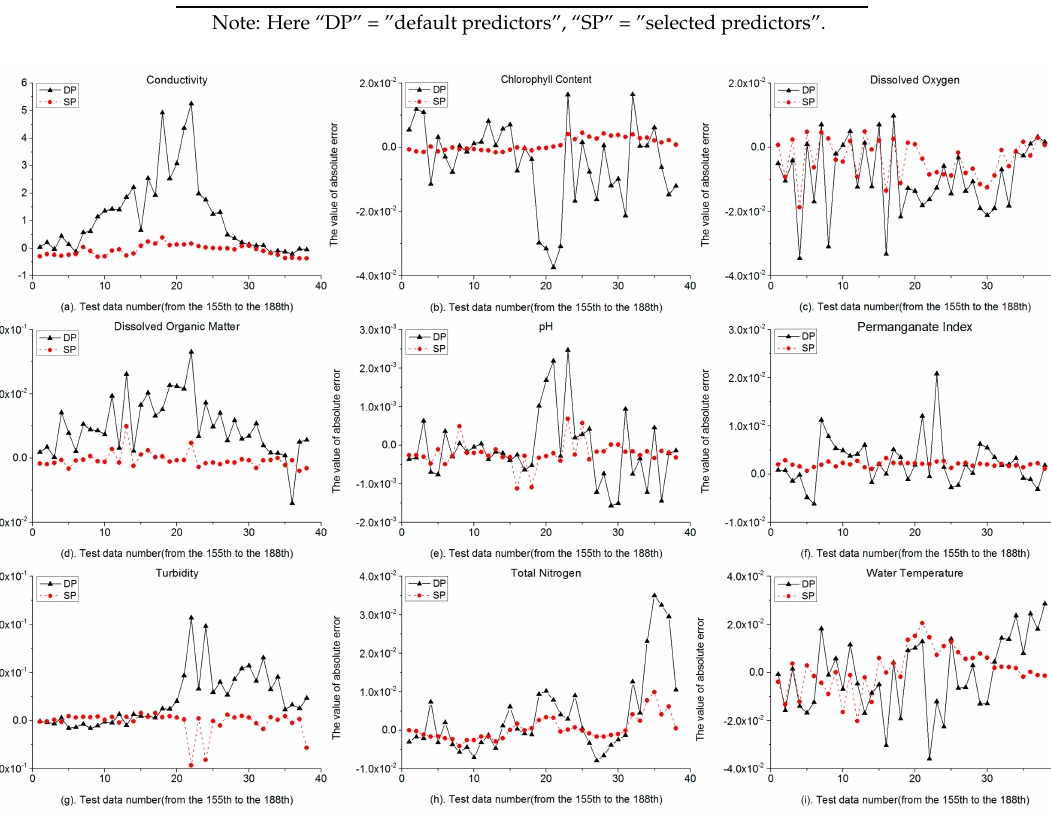
Figure 4. The absolute errors of water quality indicators of DP and SP using CS-BP